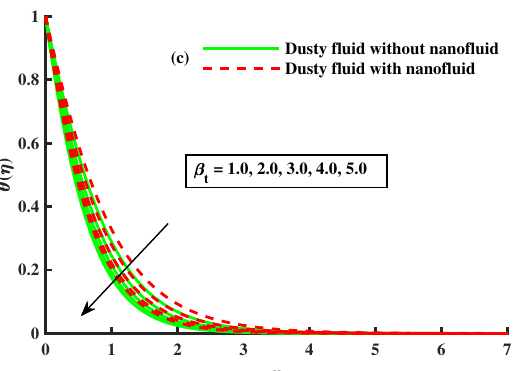
Figure 20. Fluctuation of M with nanofluid on θ ( η ) ( a ) effect of M on θ ( η ) ( b ), and β t on θ ( η ) ( c ).